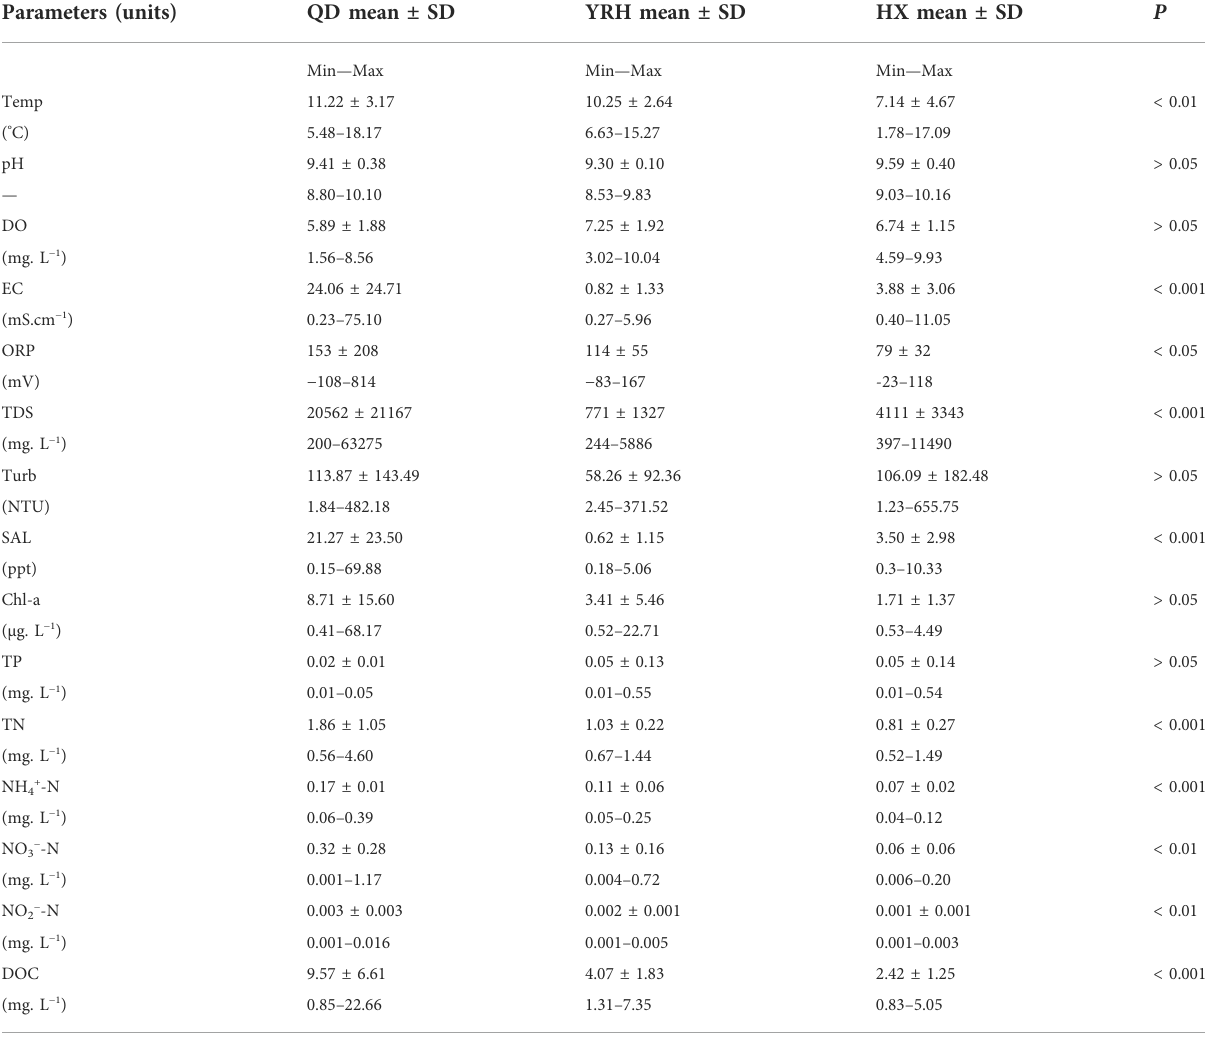
TABLE1WaterphysicochemicalparametersofthreeregionalgroupsontheQTPinJuly2020.Thedatarepresentthemeanvaluesofsamples ineach regional group with standard